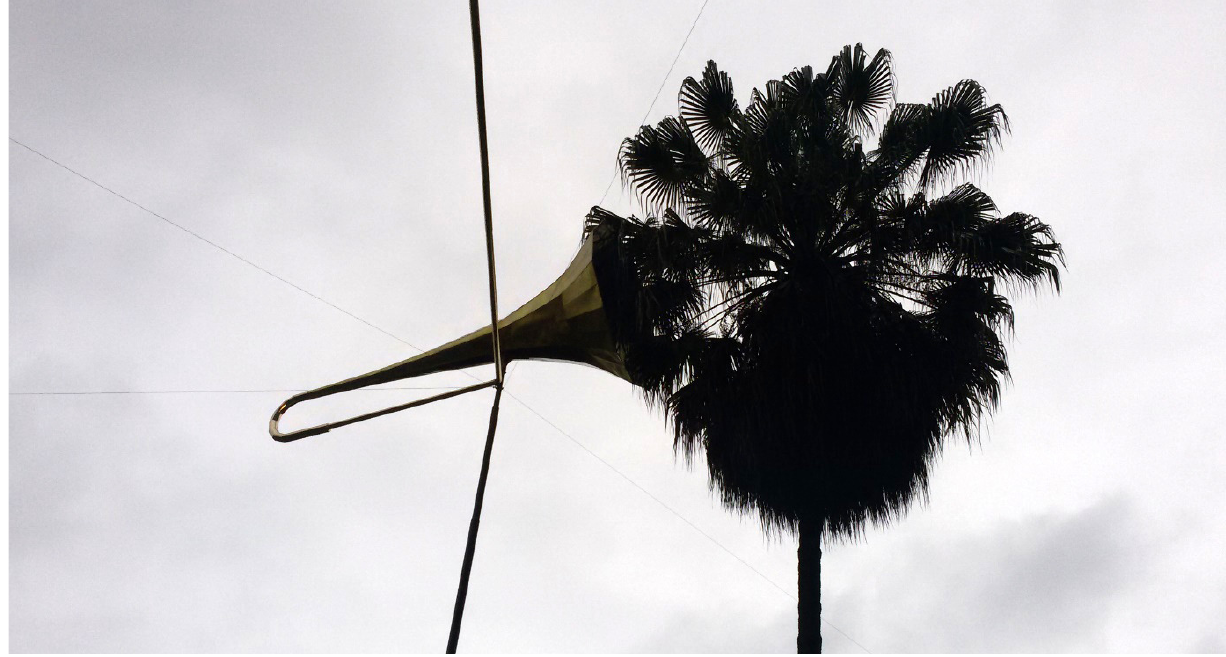
Figure 1. Sound Mirror